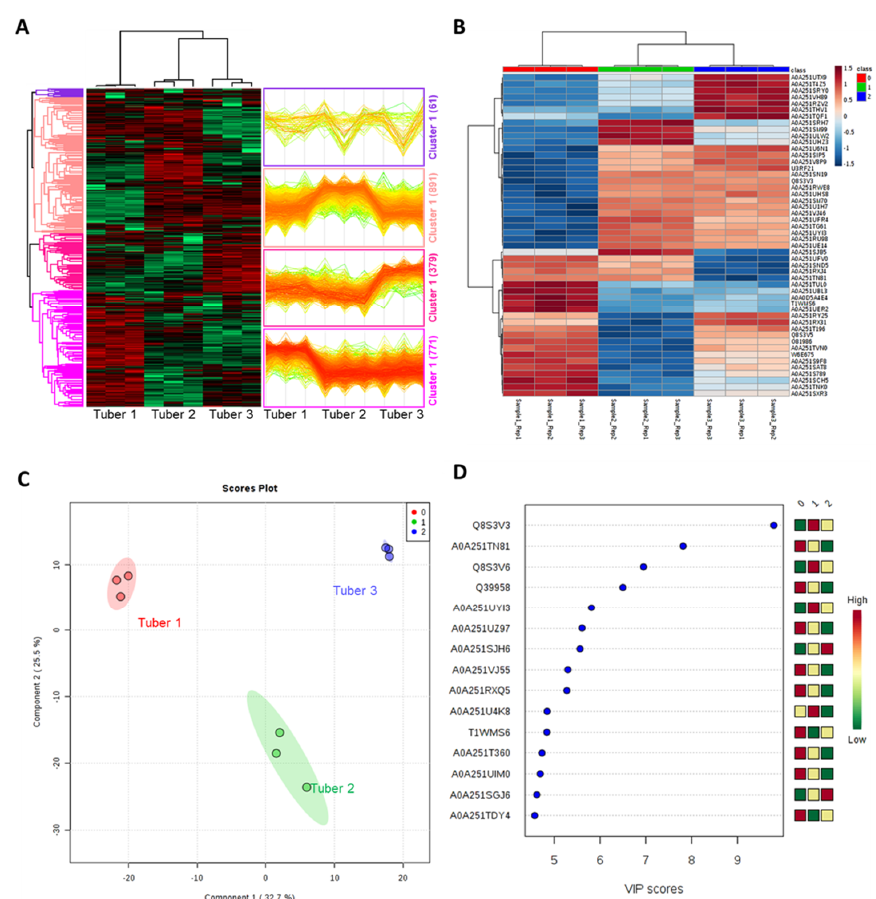
Figure 3. Statistical analysis of the JA tuber proteome. ( A ) Hierarchical clustering analysis on the total proteins from the three tubers showing differential proteins into four clusters, each with a distinct expression profile. ( B ) Heap map of top 48 differentially regulated proteins generated using MetaboAnalyst. Here, sample 1, 2, and 3 represent tubers 1, 2, and 3, respectively. ( C ) Principal component analysis of the differentially modulated proteins of tubers 1, 2, and 3. ( D ) Top 15 proteins with VIP values contributing to the separation in PLSDA plot. Here, in the color scale, 0, 1, 2 represent tubers 1, 2, and 3,